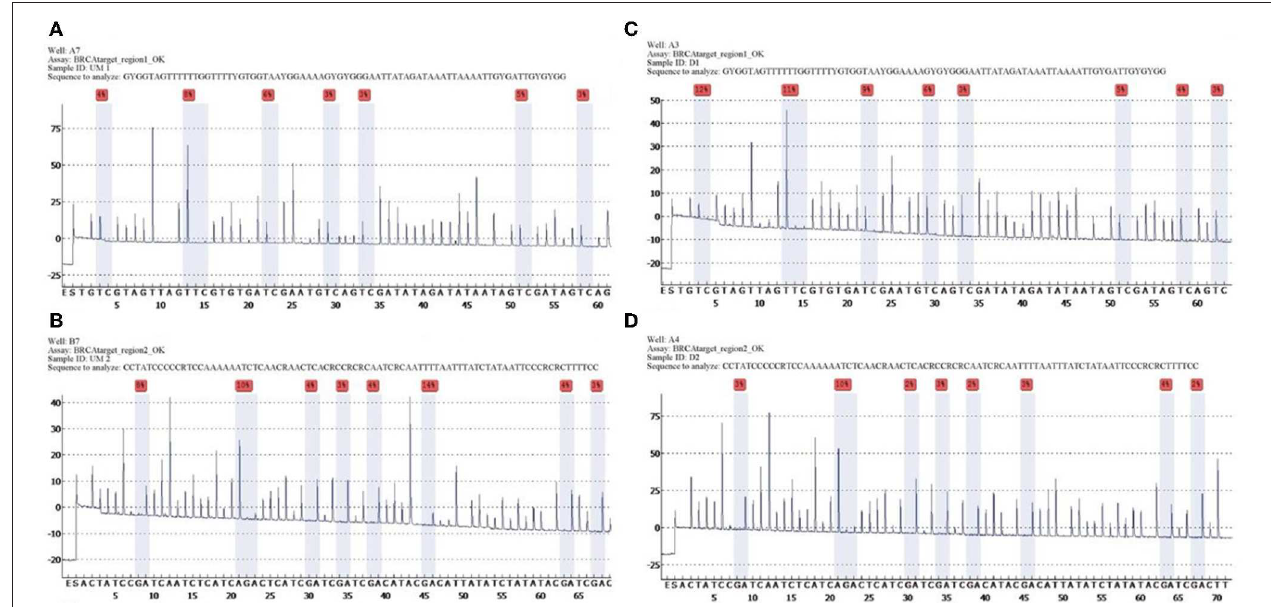
FIGURE 1 | Unmethylated control and histograms of unmethylated case 3. BRCA1 promoter methylation level in ovarian cancers quantified by pyrosequencing. The percentages (red) are the proportion of C at each CpG site after bisulfite conversion, and the methylation level of each CpG site is estimated by the proportion of C (%). An overall BRCA1 promoter methylation level is calculated as the average of the proportions of C (%) at 8 CpG sites. Representative pyrograms: (A) pyrogram of a tumor DNA showing heterogeneous levels of methylation at TC sites in the CpG island of the BRCA1 promoter. The y-axis represents the signal intensity in arbitrary units, the x-axis shows the dispensation sequence. UM Region 1 (A) , UM Region 2 (B) , case 3 Region 1 (C) , case 3 Region 2 (D)